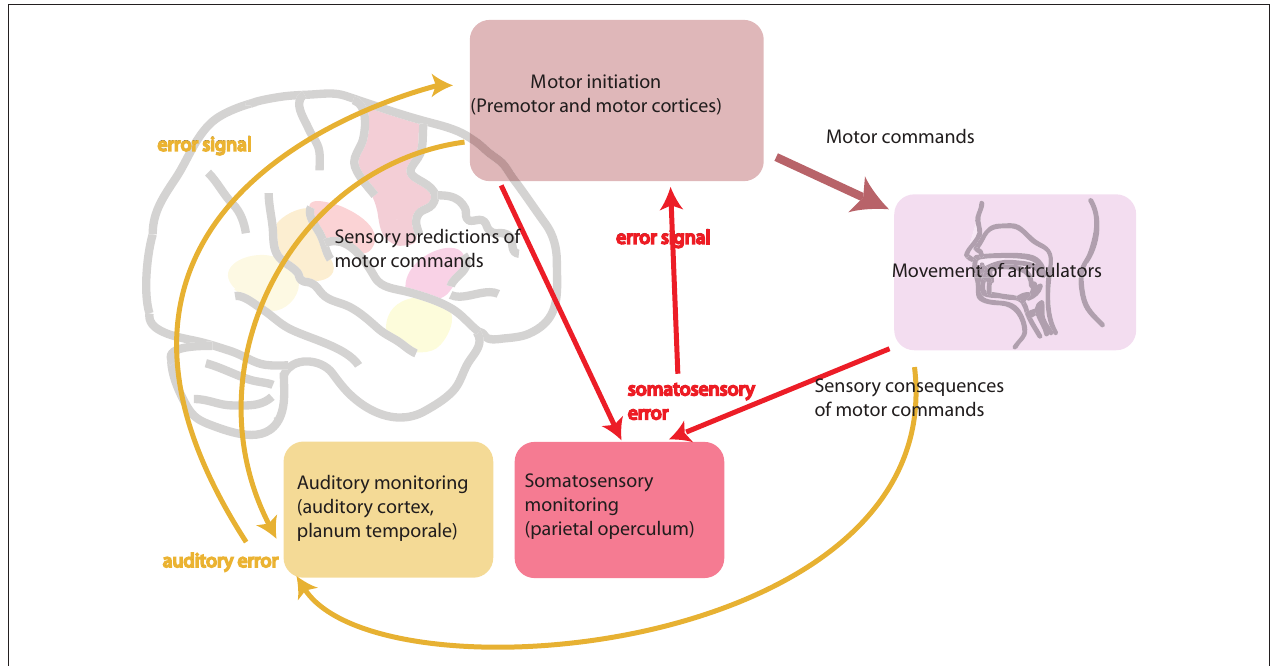
FIguRe 3 | A schematic diagram of motor–sensory systems involved in speech production. This involves feedforward motor commands and feedback sensory monitoring (both somatosensory and auditory). In bilingualism, L1 and L2 are hypothesized to use the same motor–sensory control systems. In L1 these systems